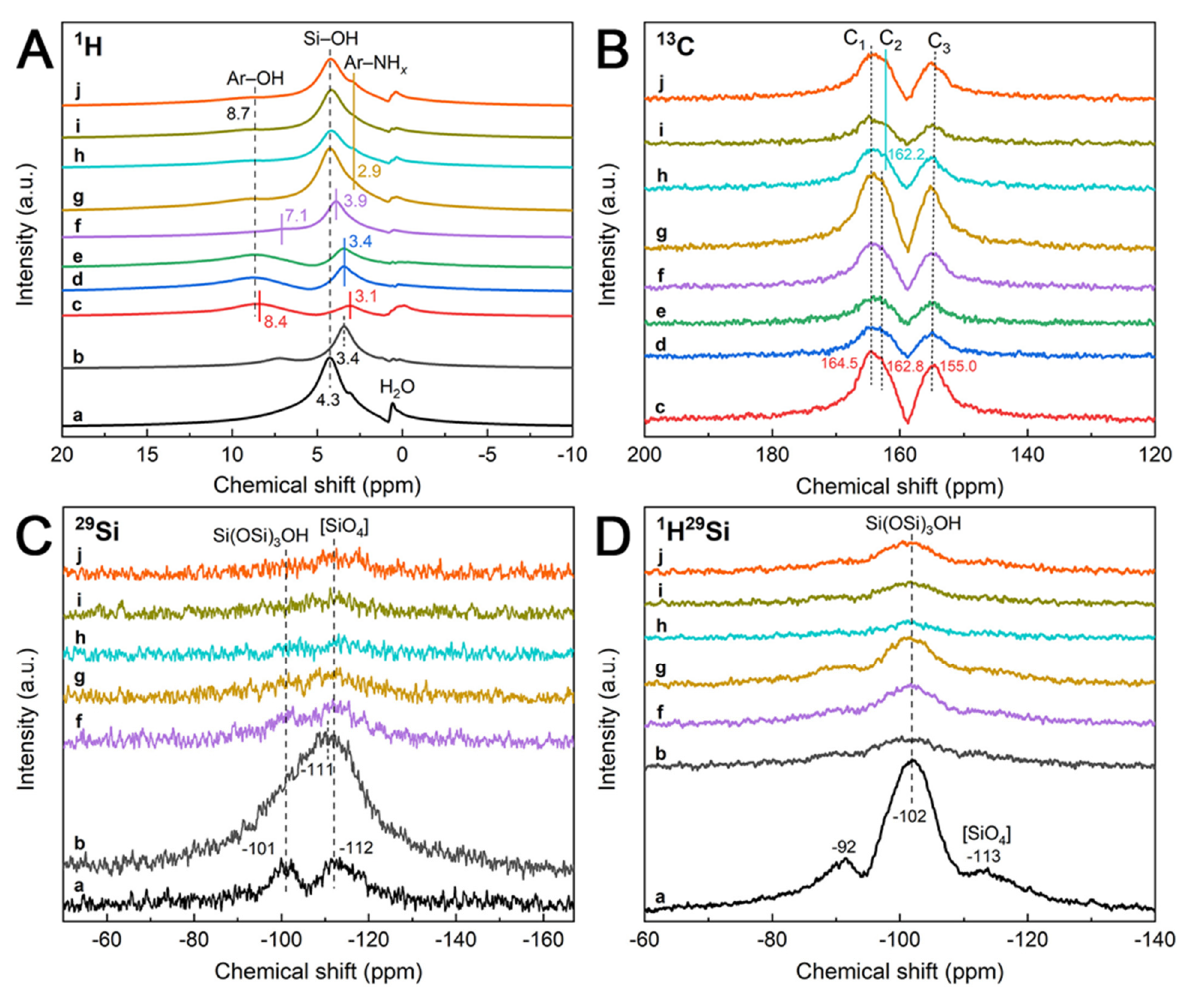
Figure 5. Solid-state ( A ) 1 H, ( B ) 13 C, ( C ) 29 Si MAS, and ( D ) 1 H 29 Si CP/MAS NMR spectra of ( a ) SiNSs, ( b ) SiNSs-550, ( c ) m-CN, ( d ) mu-CN, ( e ) u-CN, ( f ) m-CN/SiNSs, ( g ) mu-CN/SiNSs-1, ( h ) mu-CN/SiNSs-2, ( i ) mu-CN/SiNSs-3, and ( j ) u-CN/SiNSs.